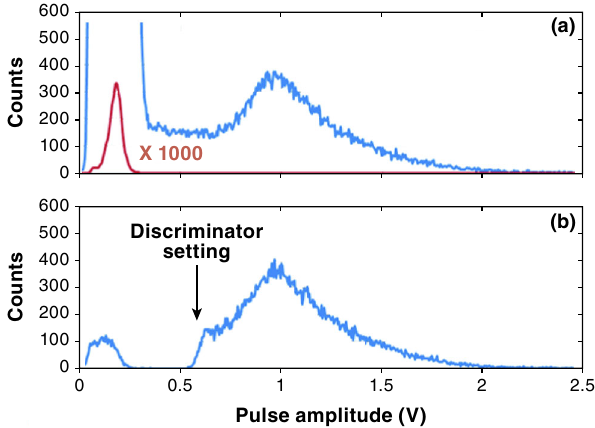
FIG. 14. Pulse height spectra from the scintillation counter used in one of the RHIC electron lenses. In the upper spectrum (a) all pulses are accepted, while in the lower one (b), pulse amplitudes below the discriminator setting are rejected. The discriminator effectively suppresses the high intensity low amplitude noise (see the red curve, which is the original histogram plotted with a scale change of a factor 1000). The small remaining peak to the left in (b) may be an artifact of the pulse height analyzer gating system. [31]. This slight pulse height reduction is illustrated in Fig. 15 which shows screen shots of counting rates as a function of pulse height from the pulse height analyzer program, M AESTRO [30]. All settings were identical and the pulse height of the light pulser peak is reduced by about 12% after two months of continuous use. This reduction may indicate slight radiation damage of the 1.2 m long light pipe and/or of the fiber carrying the light to its far end.